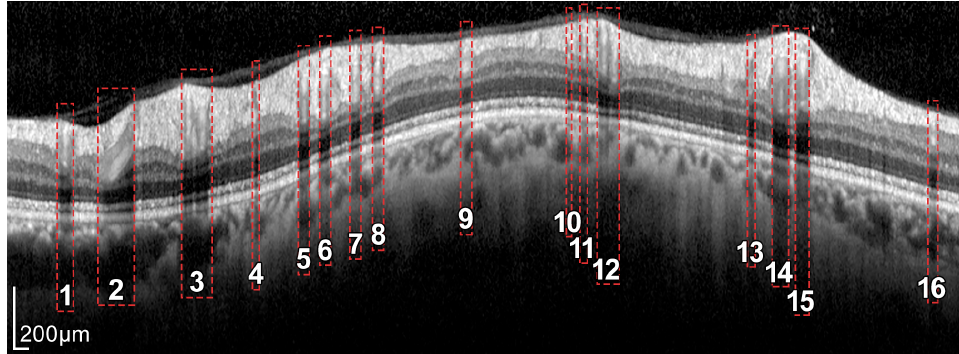
Figure 6. Intensity inhomogeneities and boundary artifacts caused by shadows cast by blood vessels. The numbers identify each of the vessels crossing the circular ray tracing depicted in Figure